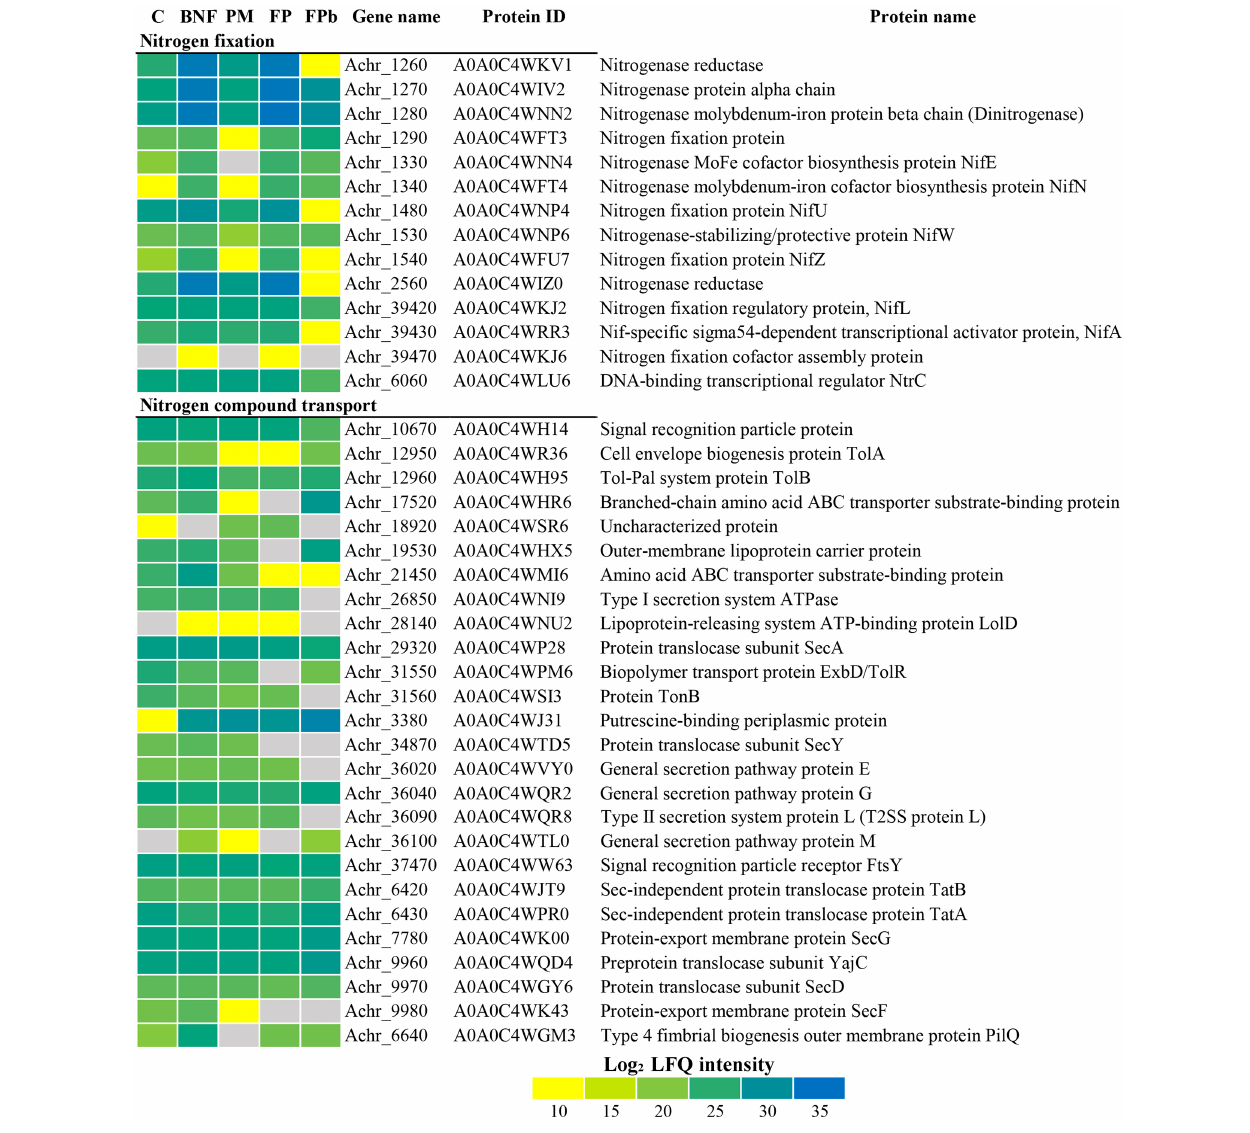
FIGURE 3 Differential expression of proteins related to nitrogen metabolism differentially expressed. Data are shown as heatmap of Log 2 normalized peptide intensity. C, control condition; BNF, biological nitrogen fixation condition; PM, phosphorus mobilization condition; FP, biological nitrogen condition and phosphorous condition (21 h); FPb, biological nitrogen condition and phosphorous condition (72